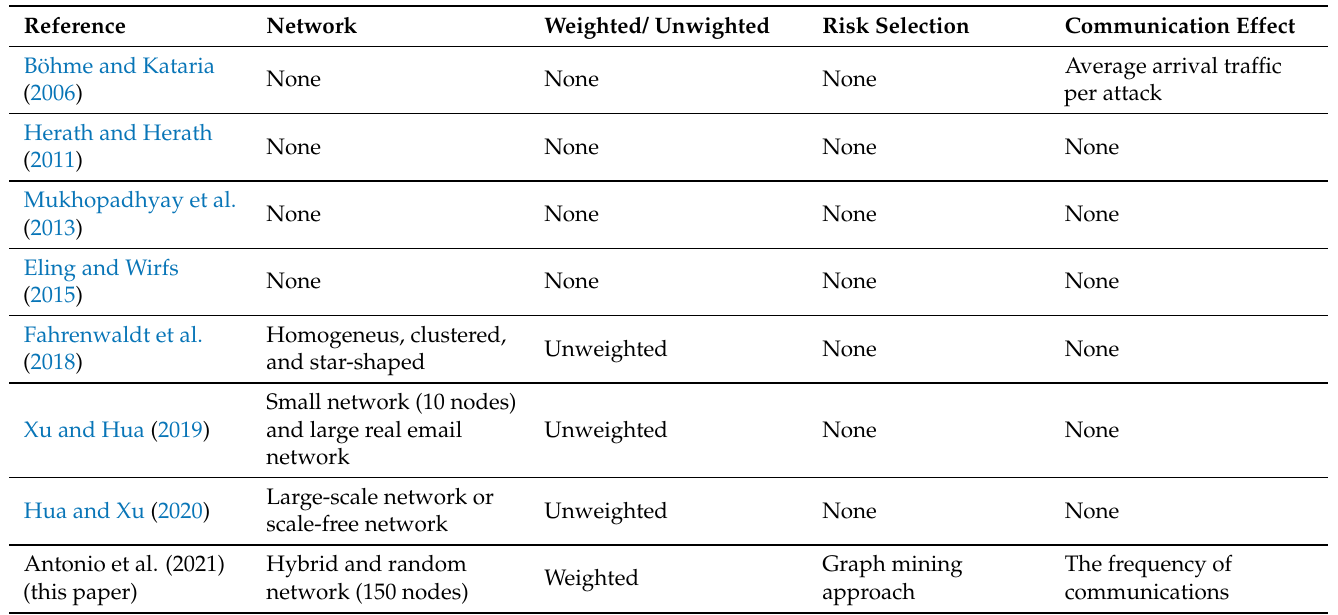
Table 2. Comparison of CIRM networks. The-state-of-the-art of our proposed network, risk selection, and communication effect.